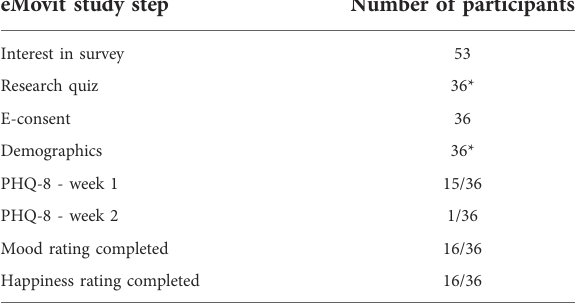
TABLE 4 Frequencies of completed research components in the eMovit